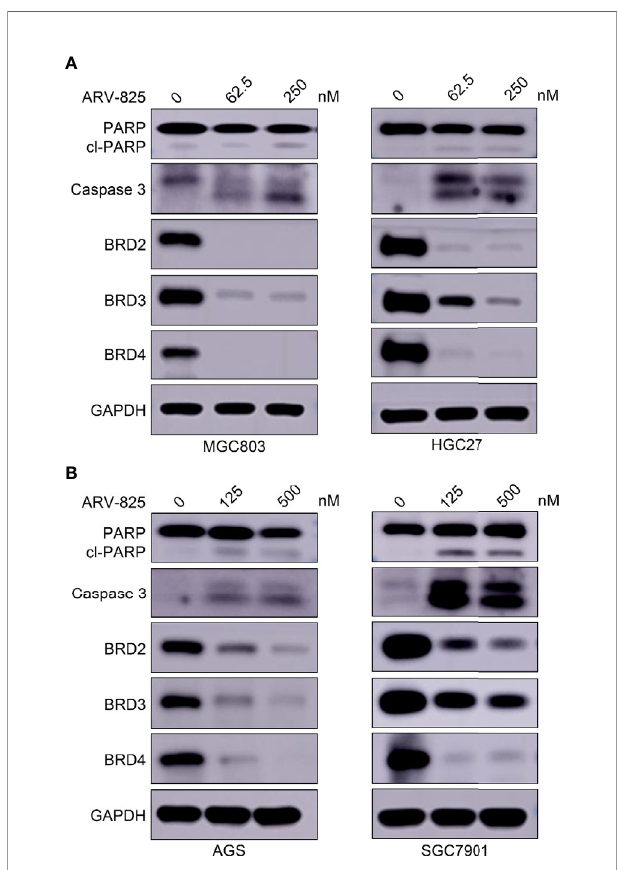
FIGURE 6 | ARV-825 degrades BET proteins in gastric cancer cells. (A) ARV-825 robustly degraded BET protein and induced caspase 3 and PARP cleavage in MGC803 and HGC27 cells. (B) ARV-825 robustly degraded BET protein and induced caspase 3 and PARP cleavage in AGS and SGC7901